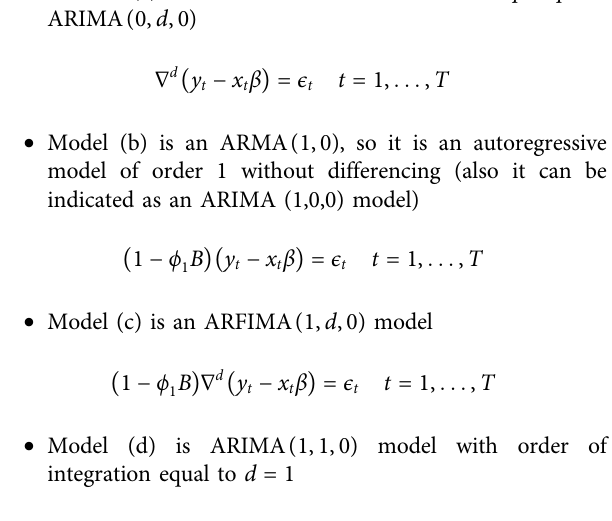
Frontiers in Earth Science |